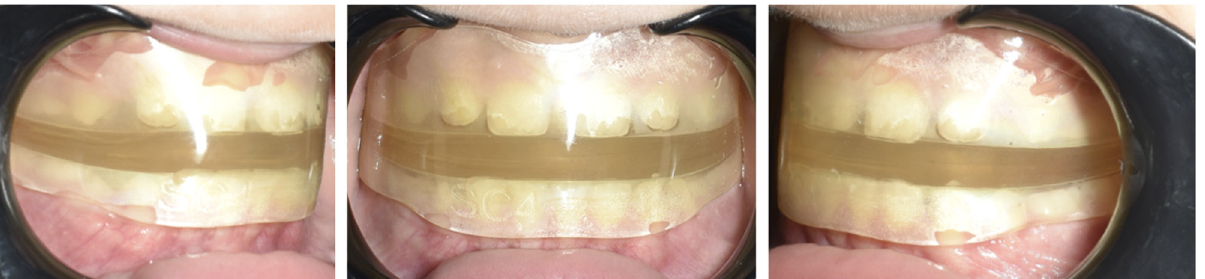
Figure 1. Elastodontic